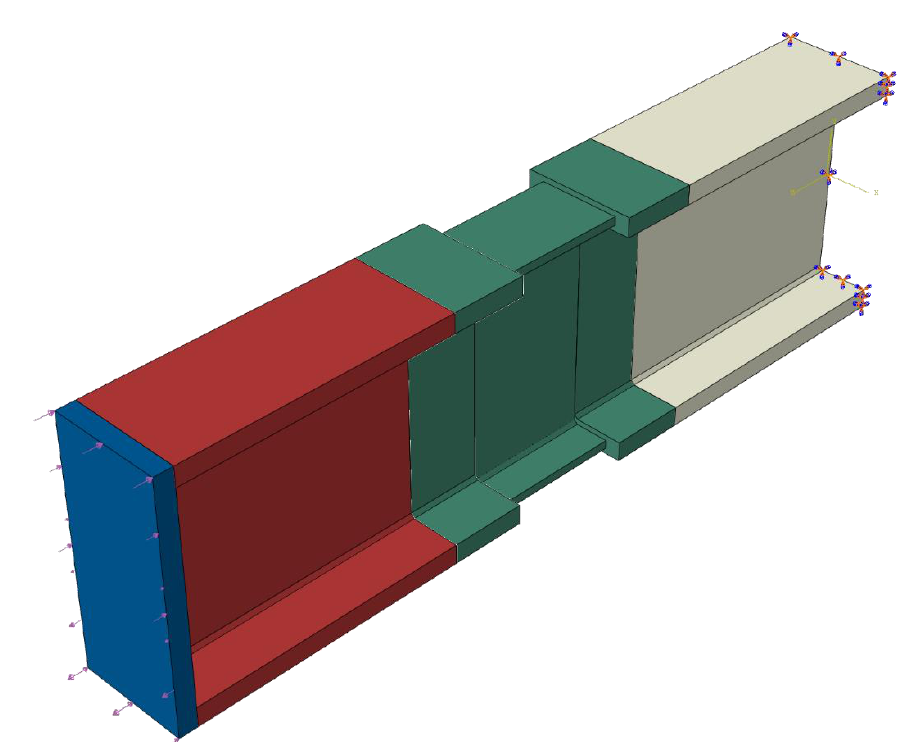
Figure 14. ABAQUS model adopted for the numerical simulation of the device related to the IPE 400 profile.